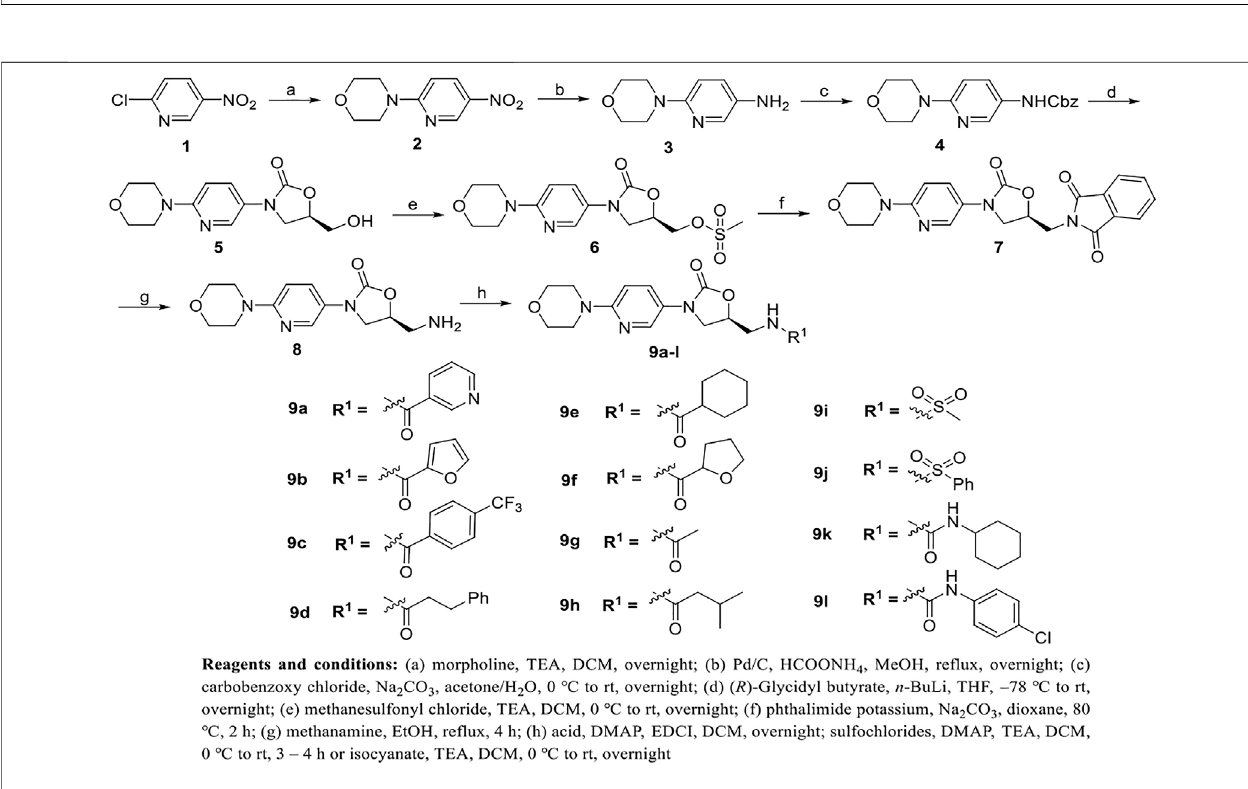
SCHEME 1 | Synthesis of target compounds 9a-l